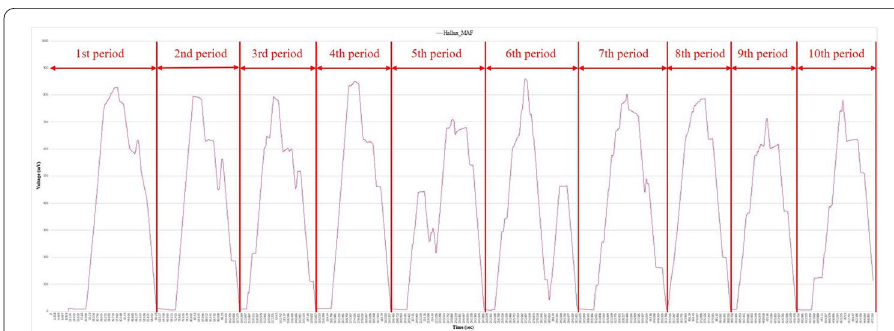
Fig. 11 Performance of MAF a Data from sensor 1, 2, and 3 b Data from sensor 1